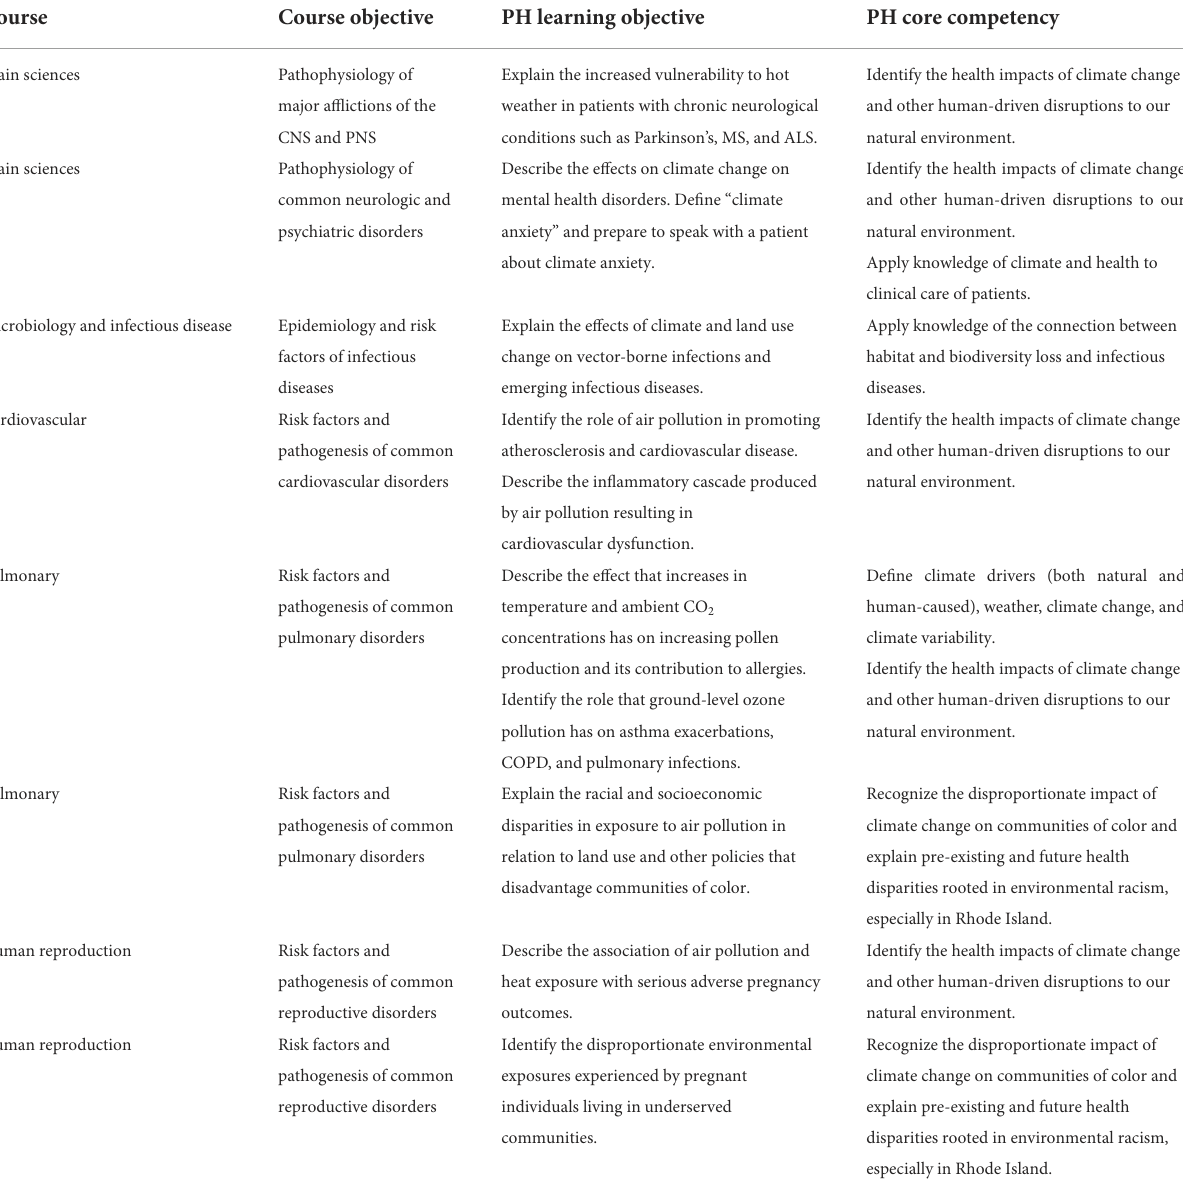
TABLE 2 Examples of planetary health learning objectives proposed within existing preclinical course